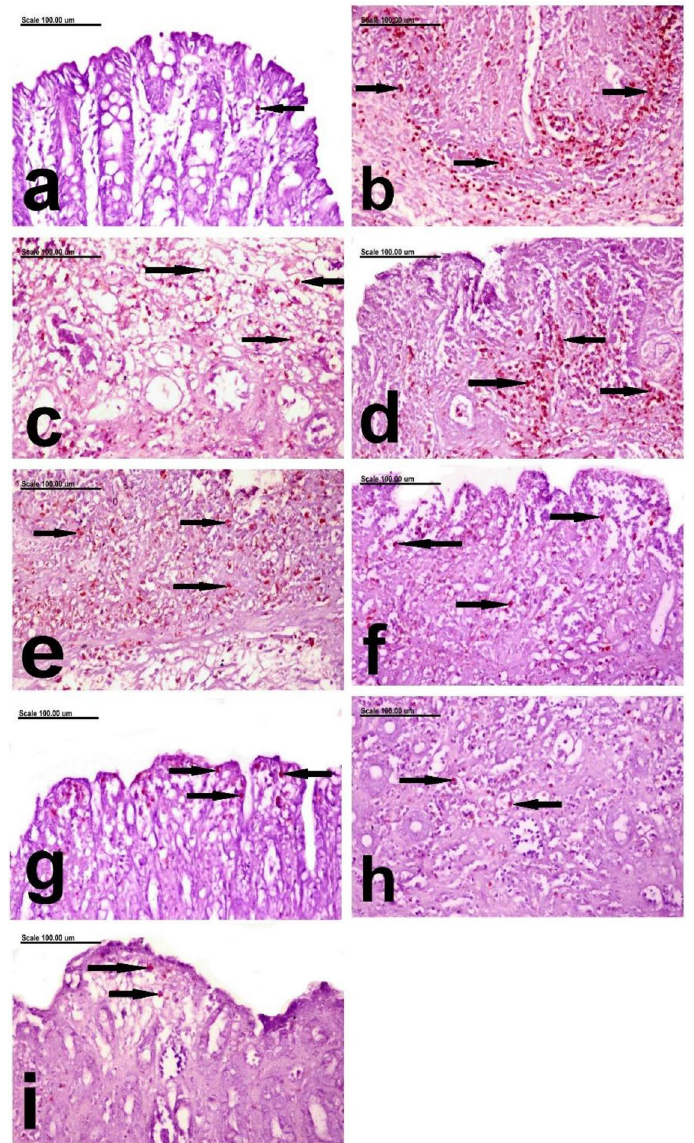
Figure 8. Photomicrograph showing the distribution of MPO-positive cells in the colonic mucosa photomicrograph from the MPO immunohistochemically-colon mucosa of, ( a ) negative control rats showing Individual MPO+ cells in the mucosa (arrow), ( b ) C+ ve group showing increase of % of MPO+ cells (arrows) in the colonic mucosa, ( c ) Prednisolone treated group showing significant decrease of % of MPO+ cells (arrows), ( d ) the low dose leave group showing increased % of MPO+ cells (arrows), ( e ) the high dose leave group showing decreased % of MPO+ cells (arrows), ( f ) low stem-treated groups showing marked decrease of % of MPO+ cells (arrows), ( g ) high dose stem-treated groups showing significant decrease of % of MPO+ cells (arrows), ( h ) low dose fruit peels treated group showing remarkable decrease of MPO+ cells (arrows), and ( i ) high dose fruit peels treated groups showing few scattered MPO+ cells (arrows).(MPO immunohistochemical staining; Scale bar = 100